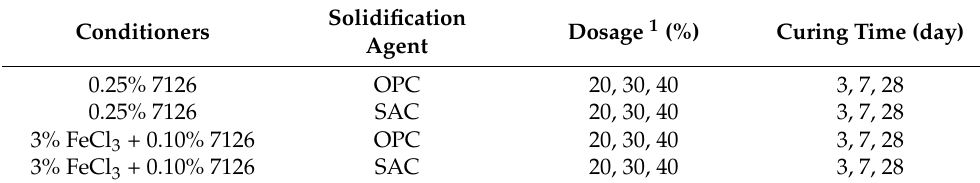
Table 4. Solidification scheme of